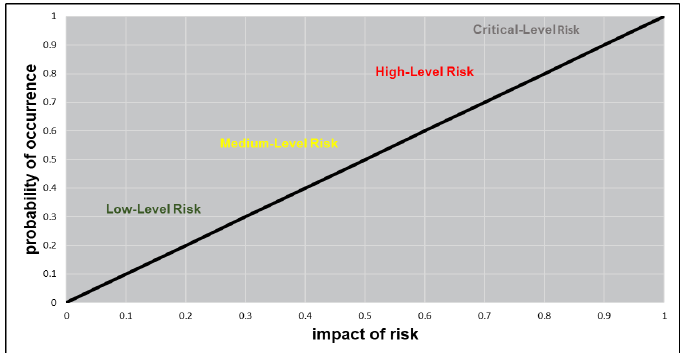
Figure 3. Risk Factor. The risk factor increases the criticality of a vulnerability when the probability of occurrence and impact is close to 1